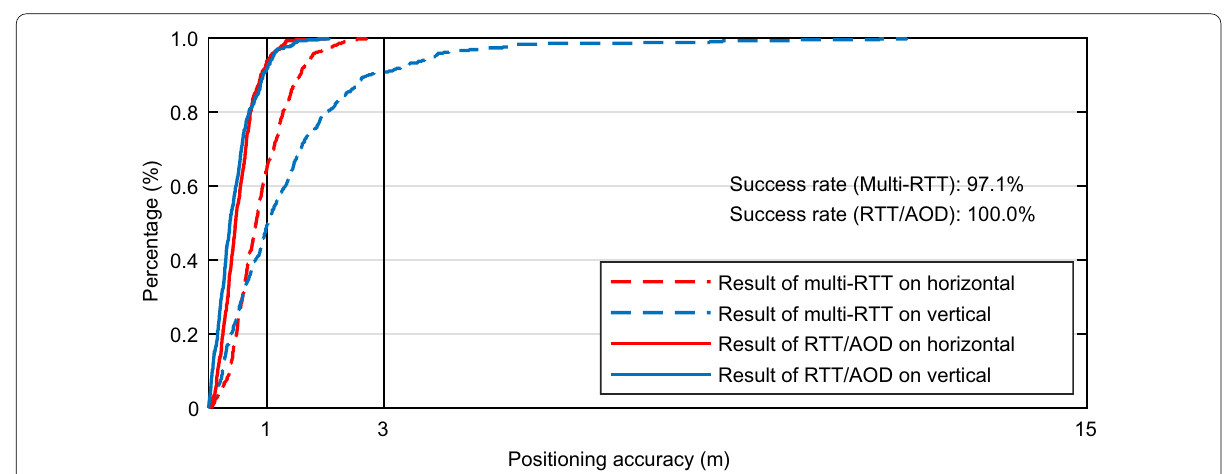
Fig. 15 The CDF of the accuracy of Multi-RTT and RTT/AOD positioning in a good